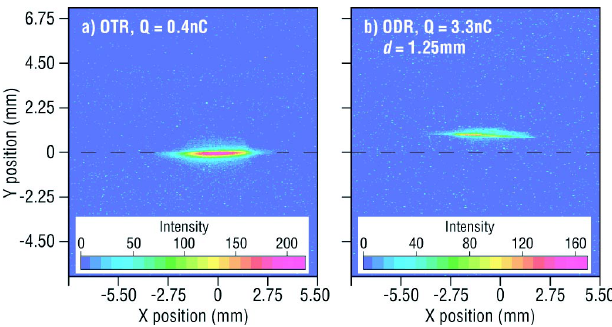
FIG. 4. (Color) Images produced by the 7-GeV beam: (a) OTR with Q (cid:5) 0 : 4 nC and (b) ODR with d (cid:5) 1 : 25 mm and Q (cid:5) 3 : 3 nC . The dashed line is the beam